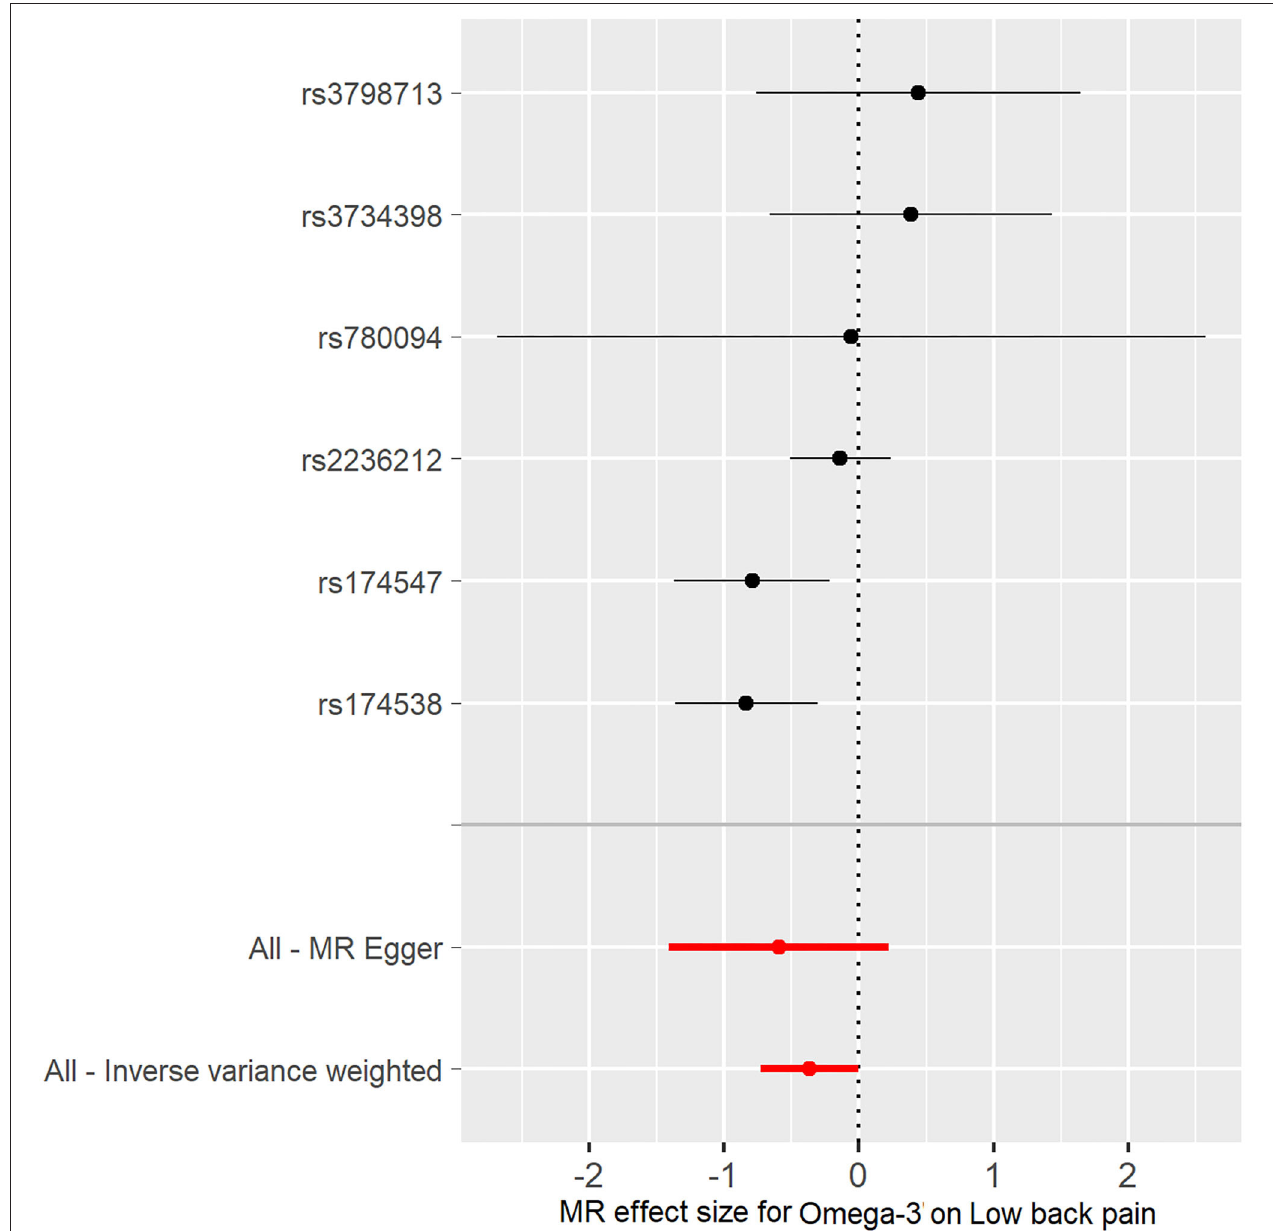
FIGURE 3 | Forest plot of omega-3 associated with risk of low back pain. The x-axis shows the MR effect size for omega-3 on low back pain. The y-axis shows the analysis for each of the